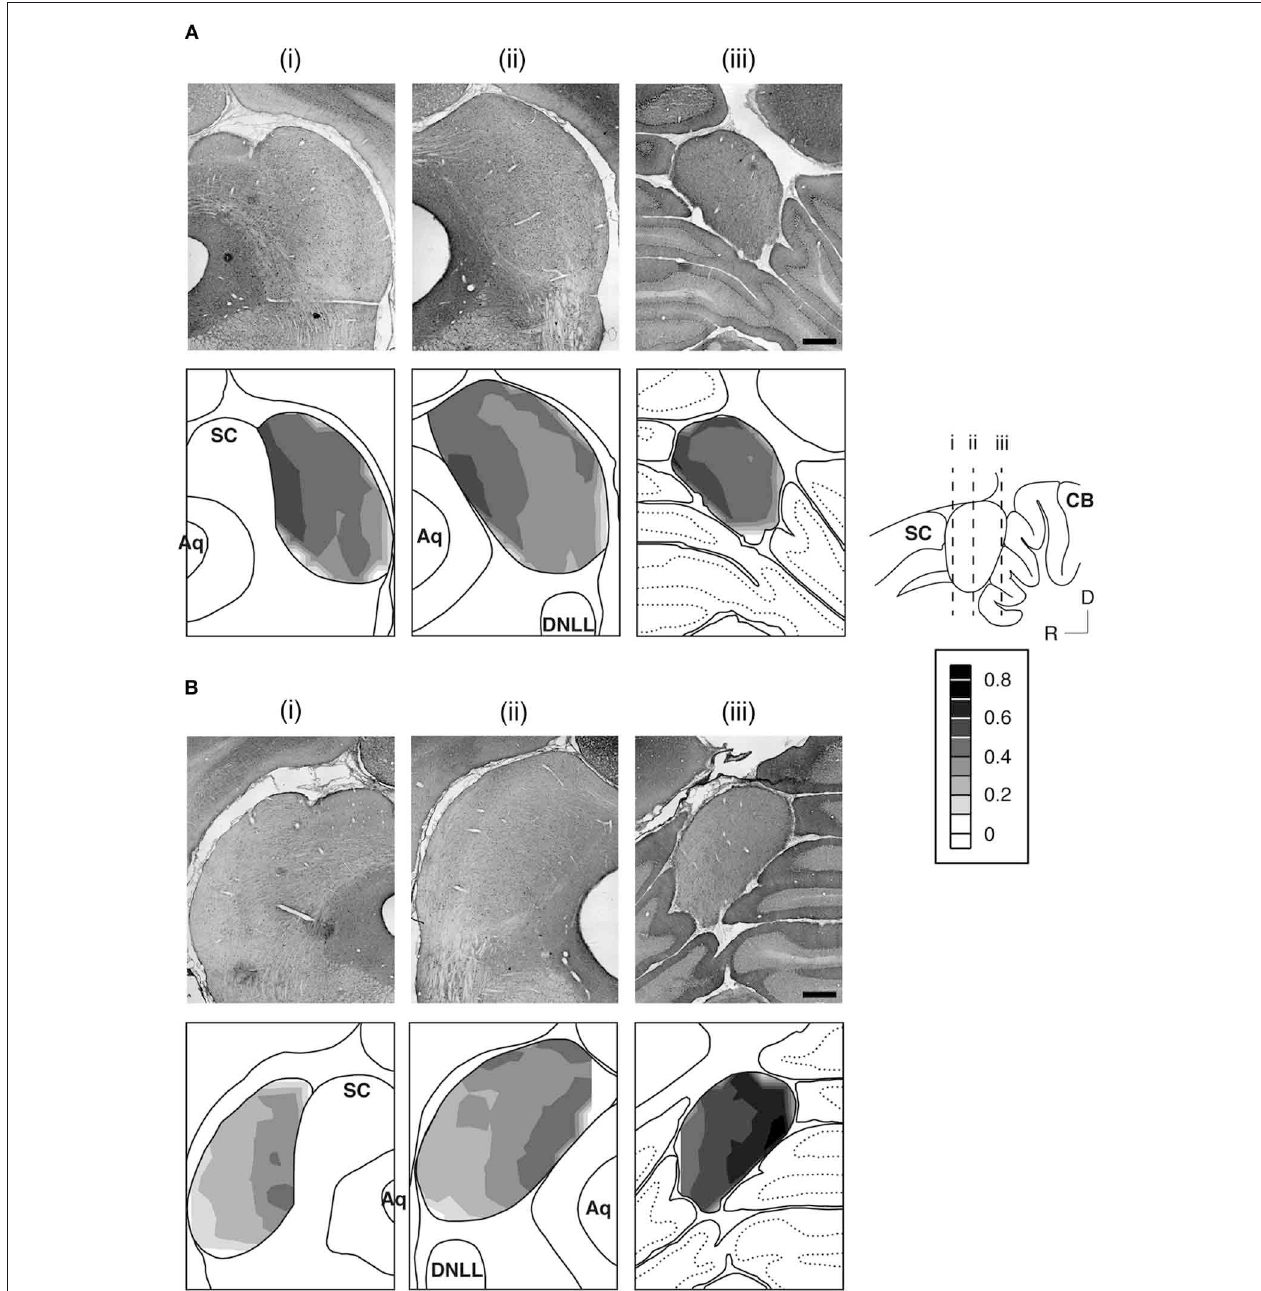
contour plot showing the distribution of a combined level of cell body and neuropil immunoreactivity over the area of the IC. For making a contour, a normalized OD was obtained for each of the alternating grid boxes over the area of the IC. Results in (A) and (B) are from a single animal. Scale bars in (A) and (B) : 500 μ